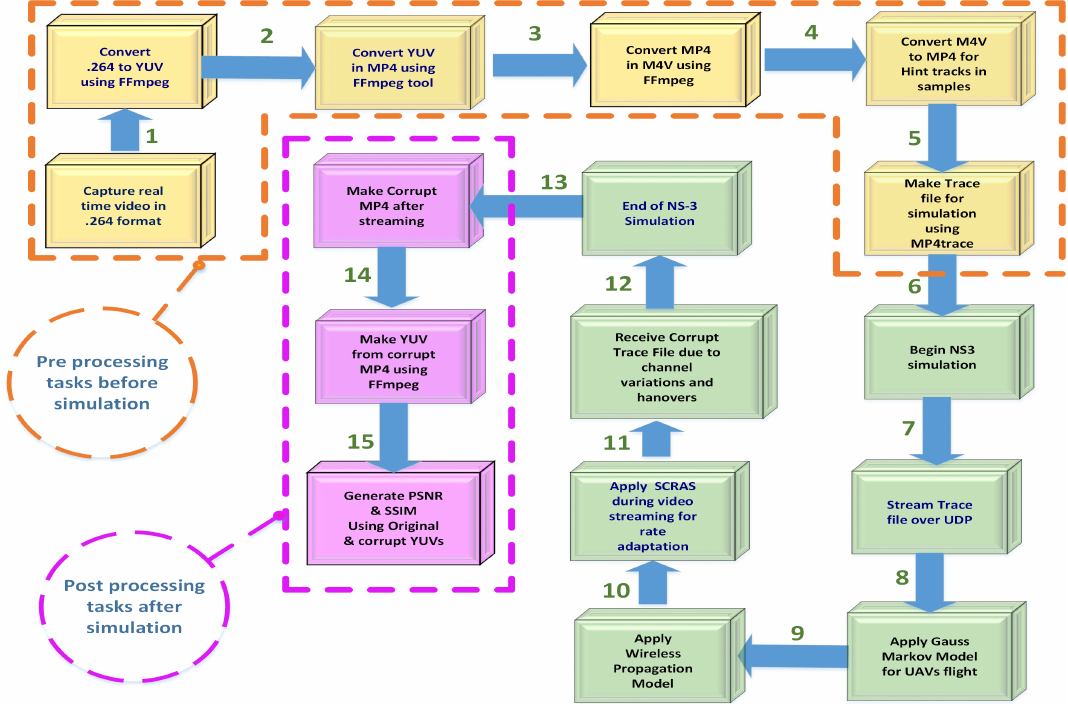
Figure 4. Complete simulation process over NS3 containing preprocessing and post-processing